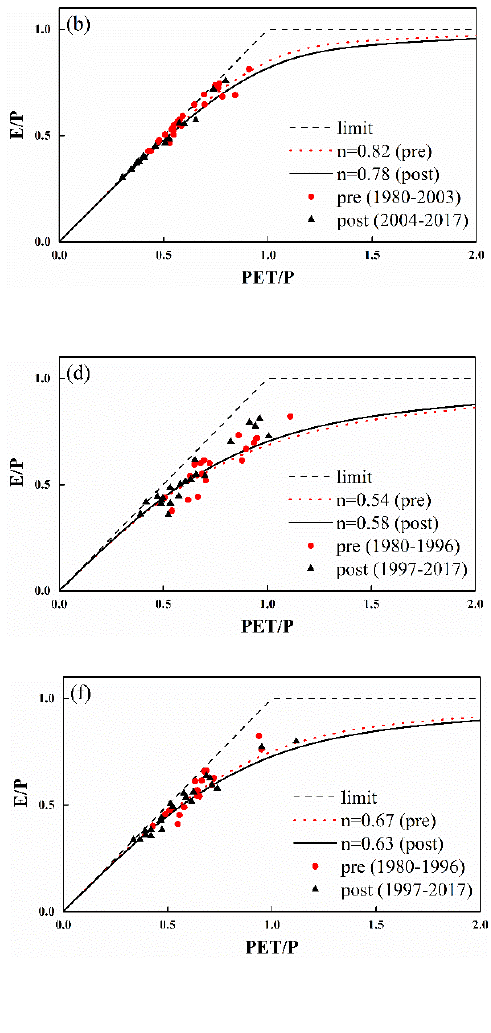
Figure 7. Comparative contributions of climate (Δ Q C ) and anthropogenic (Δ Q H ) factors impacting the streamflow change using two quantified methods. 3.5. Watershed Parameters Versus NDVI Variations The n parameter in the Budyko fitting curves, can represent the watershed characteristics, such as vegetation, soil properties, and topography to illustrate the environment condition in the river basins. According to the previous studies, the magnitude of parameter n increases as the vegetation cover becomes abundant [40,70]. Thus, to verify the condition of each river basin mentioned in the previous section, we applied the actual vegetation changes (e.g., NDVI) reflecting the observed